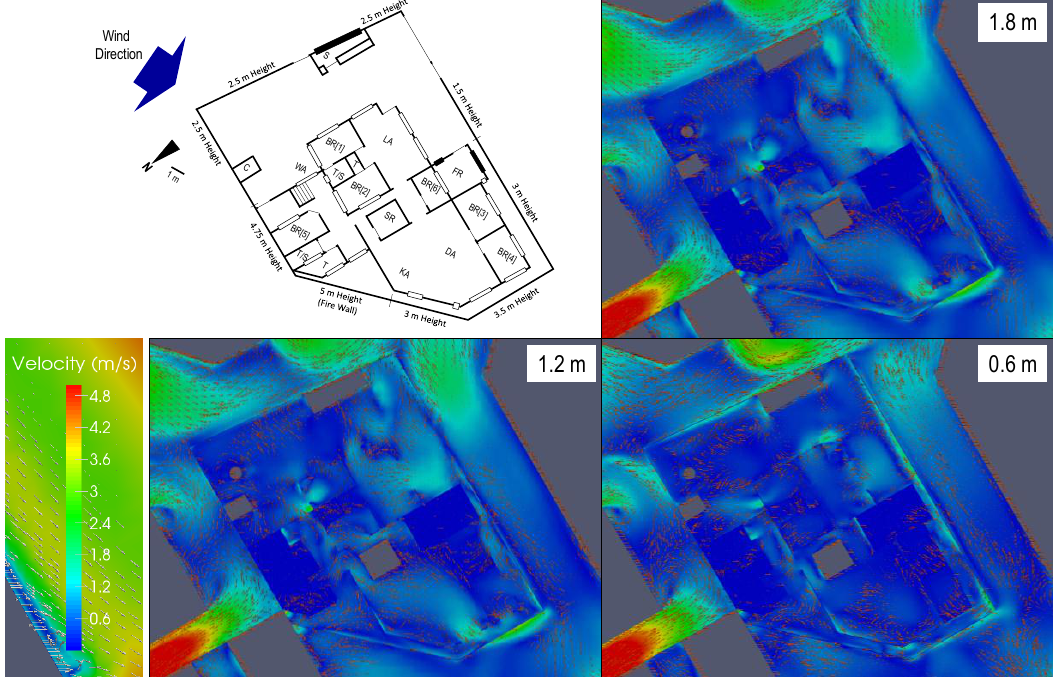
Figure 10. Case 5—High lot perimeter wall and firewall (all windows opened and all doors closed) wind velocity around and inside the detached family house for three vertical heights (1.8 m, 1.2 m, and 0.6 m above the floor).